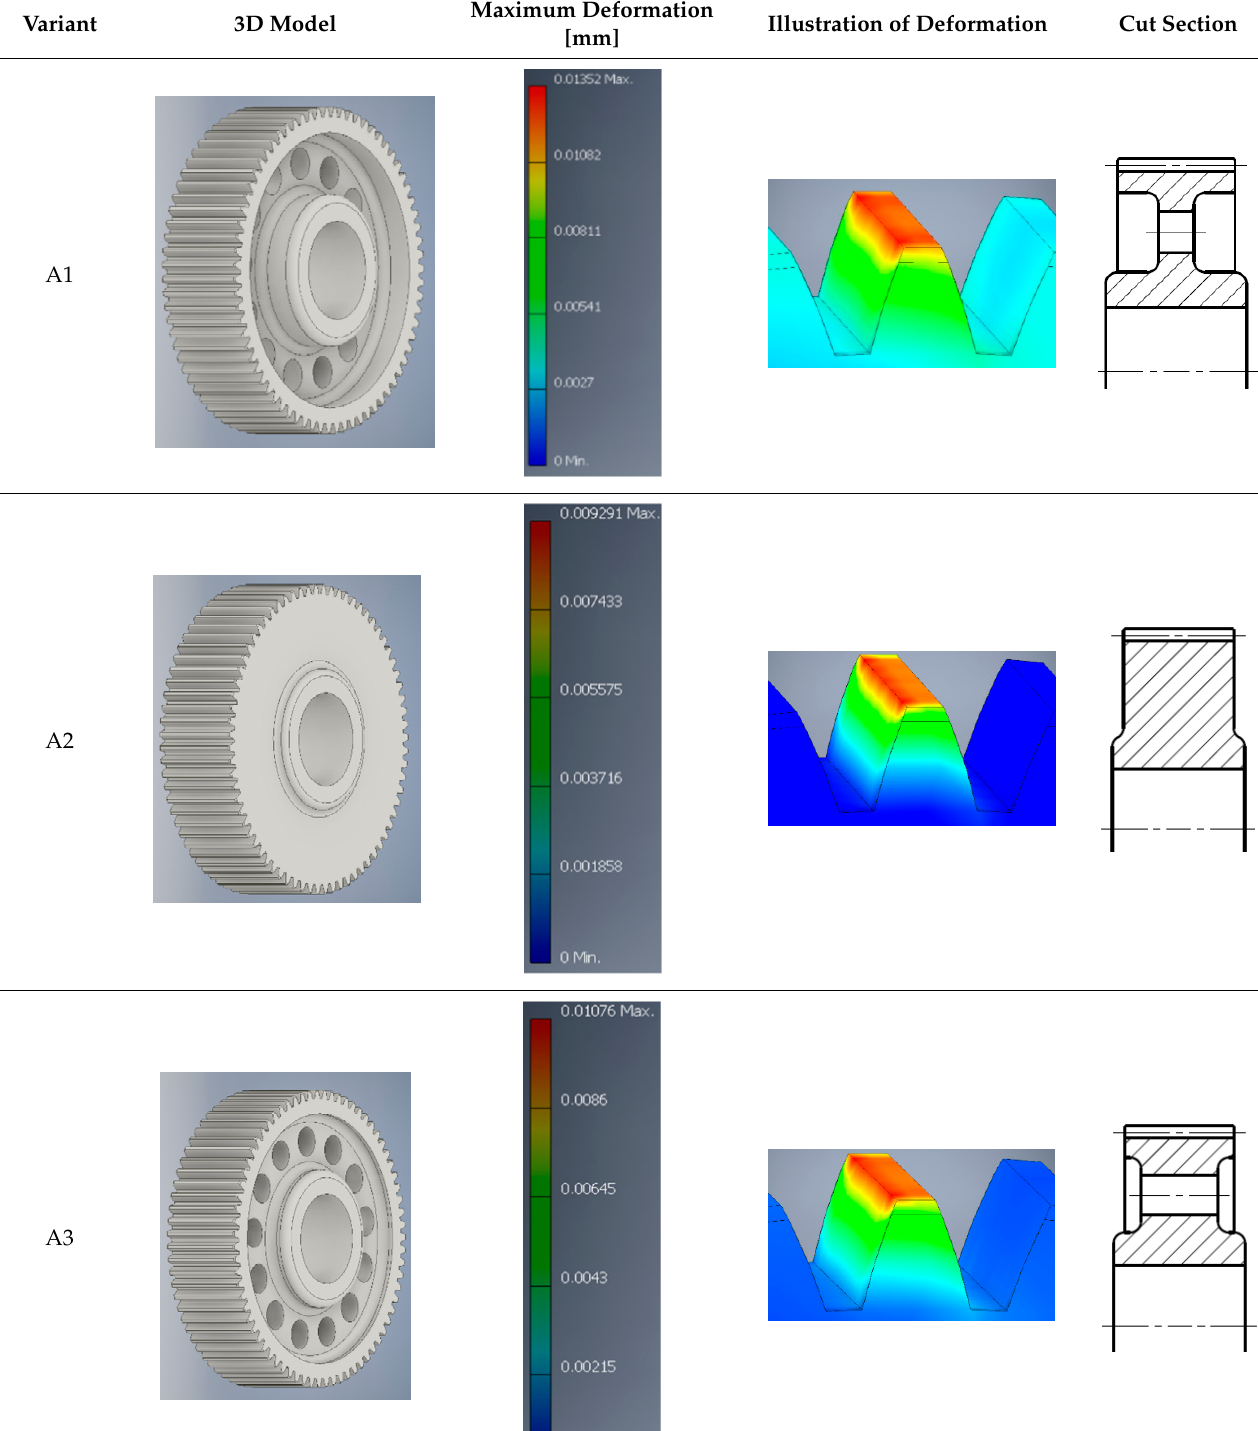
Table 6. Gear deformations at the load point for the designed models of forged wheels.